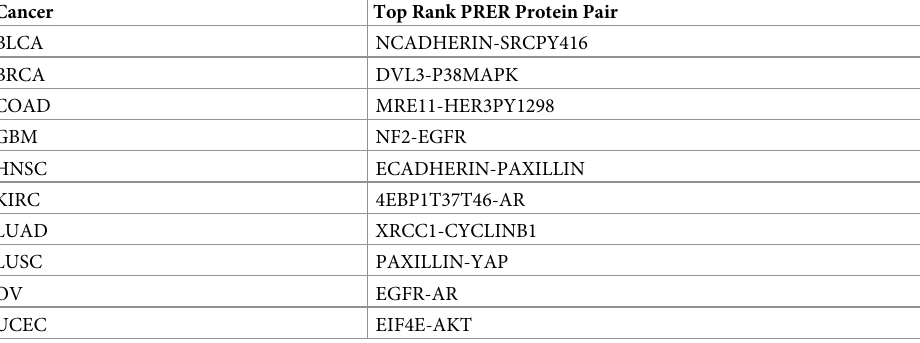
Table 2. The top PRER feature in each cancer type. The relative expression level of this feature is found to be impor- tant in the RSF model. The gene symbols of the corresponding gene are listed. The letter P after the gene symbol indi- cates that this is the phosphorylated version of the protein. The type of phosphosite and its residue number is provided.